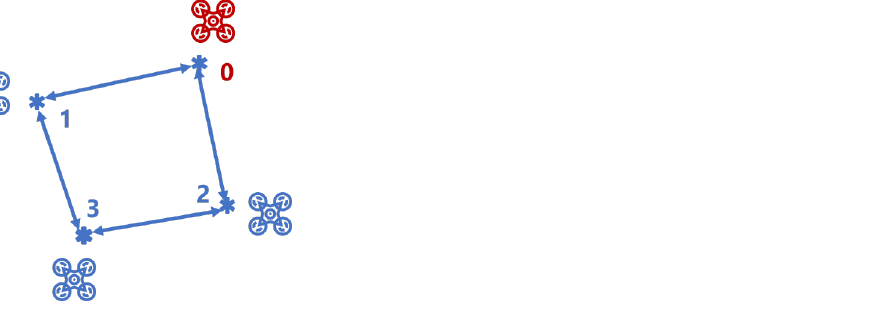
Figure 1. The communication topology of unmanned aerial vehicles